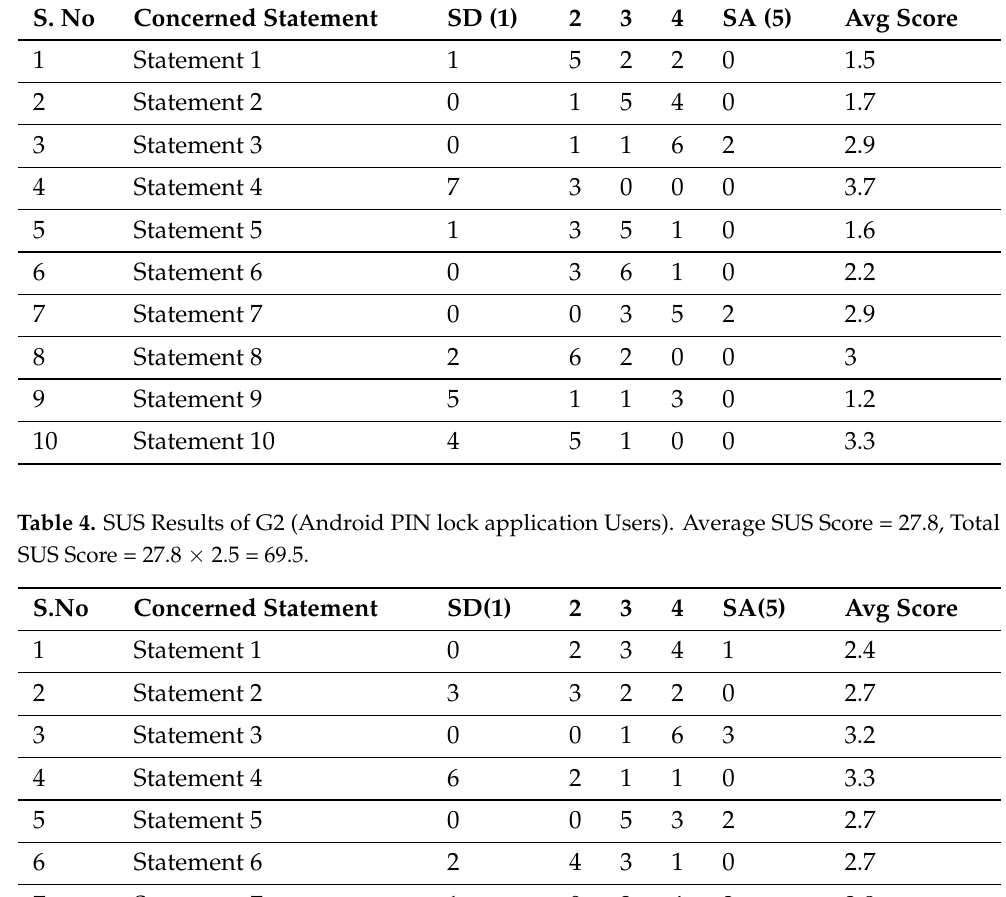
Table 3. SUS results of G1 (Android pattern lock application users). Average SUS Score = 24, Total SUS Score = 24 × 2.5 = 60.